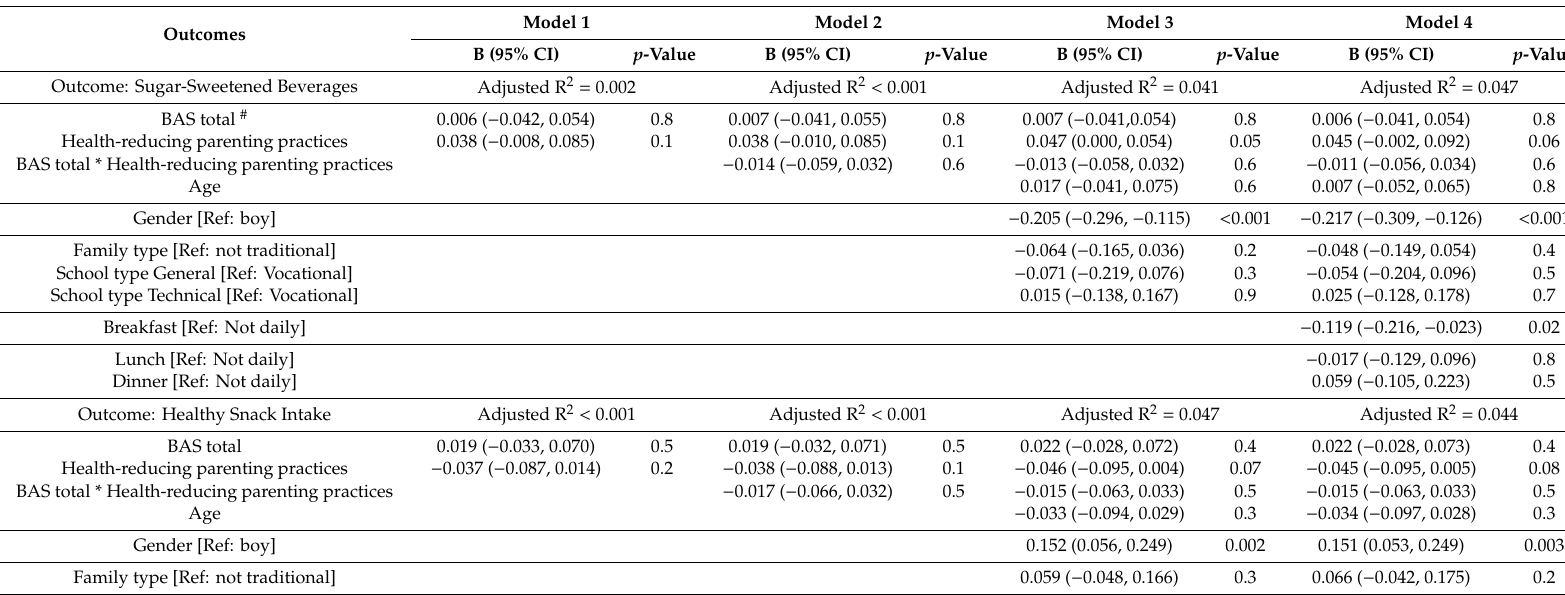
Table A4. Associations between reward sensitivity and adolescents’ intake of sugar-sweetened beverages, healthy and unhealthy snacks, and the moderating role of (adolescent-reported) Health-reducing parenting practices for complete cases excluding diet outliers ( n =